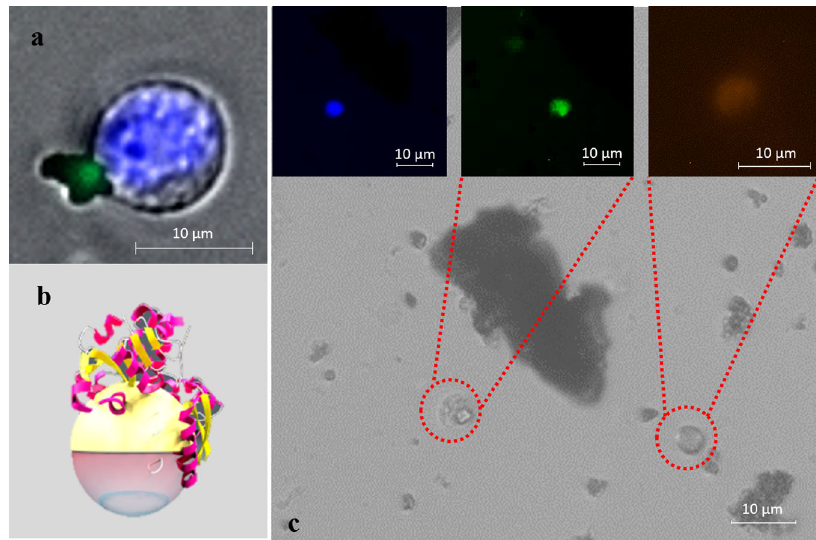
Fig. 4 Images of cancer cells captured by MFN from blood samples. a HCT116 cell captured by MFN conjugated with Cy5. Cell visualized by nuclear staining with Hoechst reagent (blue) and Cy5 (green). b Schematic of the MFN conjugated with Tf/Ab. c Immunocytochemistry method based on Fluorescein Isothiocyanate-labeled anti-cytokeratin (green), and Hoechst (blue) nuclear staining was applied to identify and enumerate CTCs captured by MFNs. PE-labeled anti-CD45 (red) and Hoechst (blue) nuclear staining was used to identify